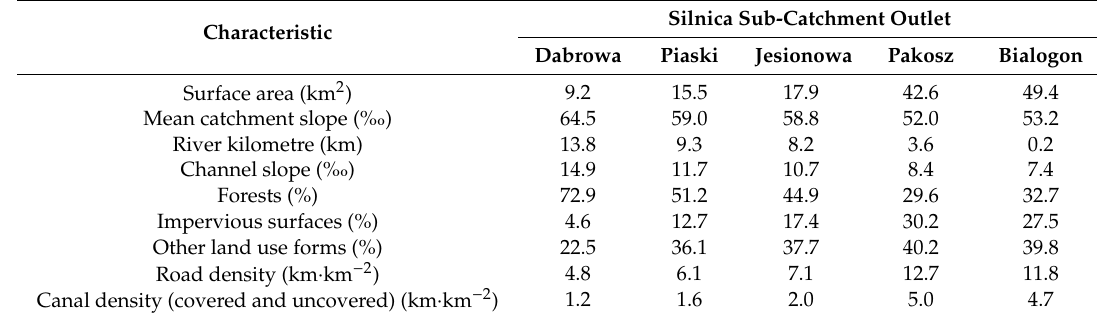
Figure 1. Land use and hydrometric stations in the Silnica catchment (1—hydrometric stations, 2—main watershed, 3—watershed of sub-catchments, 4—streams, 5—roads, 6—water reservoir, 7—forest, 8—green areas, 9—arable land, 10—impervious areas). Table 1. Silnica catchment area with selected types of land use and development indicators.